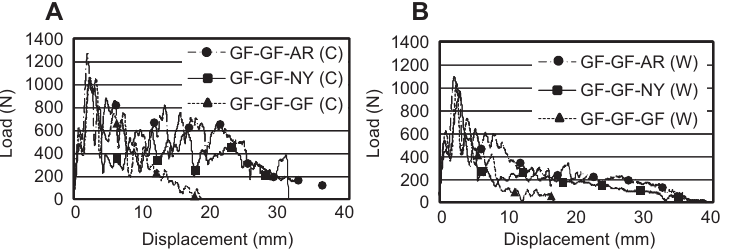
Figure 4 Load-displacement curves of the BWK composites during the three-point bending impact test – effect of stitch yarn: (A) course (C) direction and (B) wale (W)